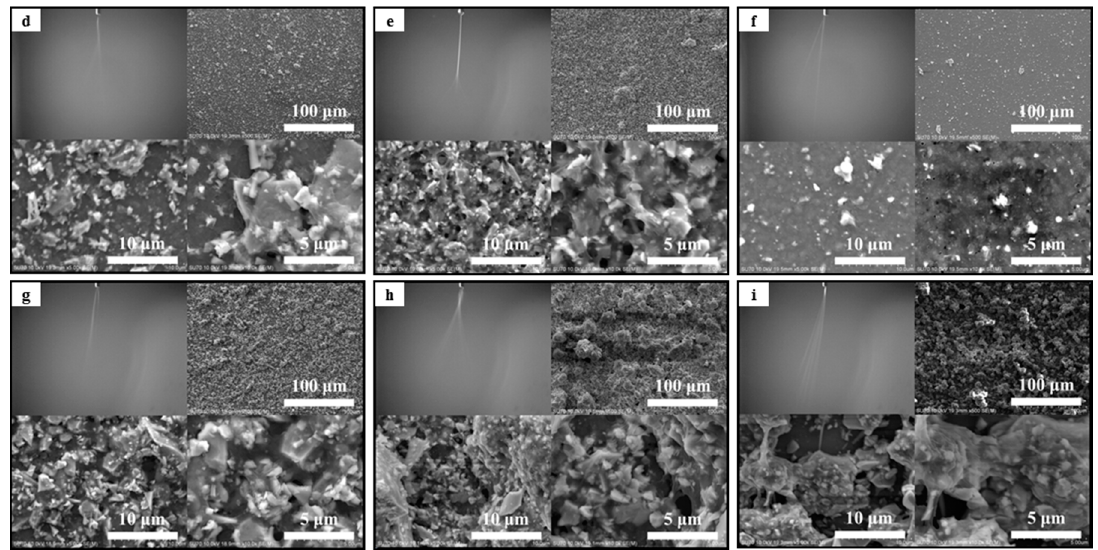
Figure 2. Images of spray plume and deposition film on silicon substrate (glass frit in ethanol, inner diameter of capillary nozzle 340 μ m, electrode gap 11.5 cm, deposition time 120 s): ( a ) concentration 10 wt %, voltage 7.5 kV, flow rate 750 μ L/h; ( b ) concentration 10 wt %, voltage 8.5 kV, flow rate 1000 μ L/h; ( c ) concentration 10 wt %, voltage 9.5 kV, flow rate 1250 μ L/h; ( d ) concentration 15 wt %, voltage 7.5 kV, flow rate 1000 μ L/h; ( e ) concentration 15 wt %, voltage 8.5 kV, flow rate 1250 μ L/h; ( f ) concentration 15 wt %, voltage 9.5 kV, flow rate 750 μ L/h; ( g ) concentration 20 wt %, voltage 7.5 kV, flow rate 1250 μ L/h; ( h ) concentration 20 wt %, voltage 8.5 kV, flow rate 750 μ L/h; ( i ) concentration 20 wt %, voltage 9.5 kV, flow rate 1000 μ L/h.